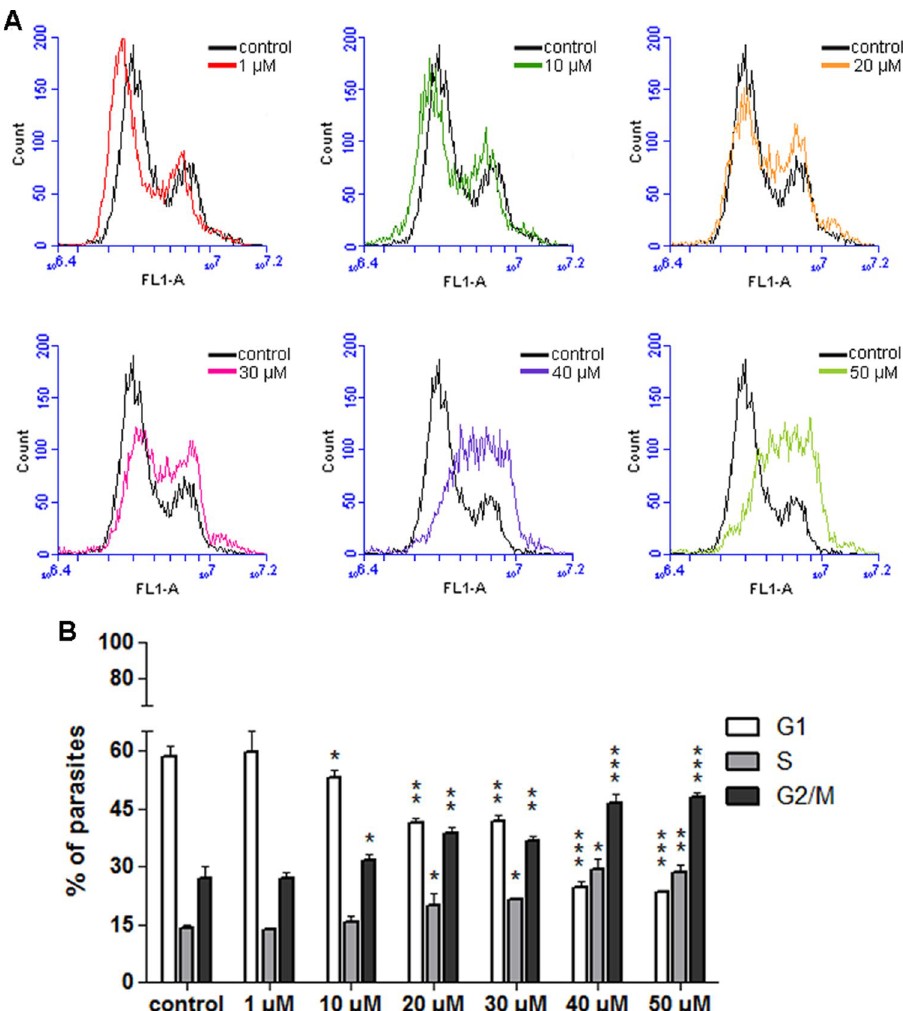
Figure 10. Epimastigotes cell cycle in the presence of FEX for 72 h. ( A ) Histograms of control and treated parasites. Black and color lines indicate untreated and treated epimastigotes, respectively. ( B ) Percentage of parasites in G1, S, and G2/M. In the control group, most epimastigotes were in the G1 phase, followed by S and G2/M. From 10 µM, there was a lower number of parasites in G1 and a higher percentage in G2/M. This pattern became more pronounced at higher concentrations. The histograms are representative and the data are the average of two independent experiments (*p > 0.05; **p < 0.05; ***p <